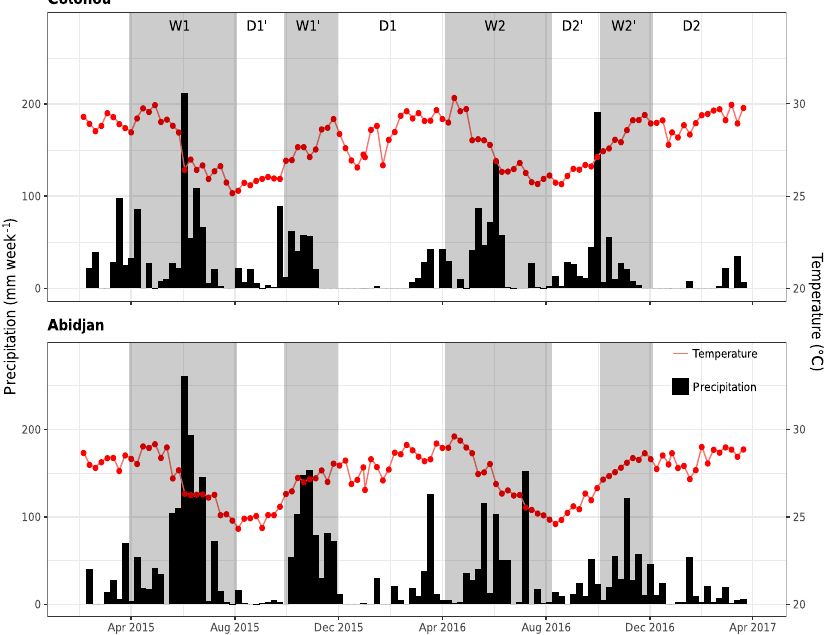
Figure 6. Weekly precipitation rate and mean temperature for Cotonou and Abidjan from February 2015 to March 2017. W1 and W2, the long rainy seasons; D1 (cid:48) and D2 (cid:48) , the short dry seasons; W1 (cid:48) and W2 (cid:48) ; the short rainy seasons; and D1 and D2, the long dry seasons for all the study period. Table 1. Seasonal average of precipitations, wind speed, aerosol optical depth (AOD) and Ångström exponent for Abidjan and Cotonou sites. W and W (cid:48) are the long and short rainy seasons and D and D (cid:48) are the long and short dry seasons, respectively. City Season Number of